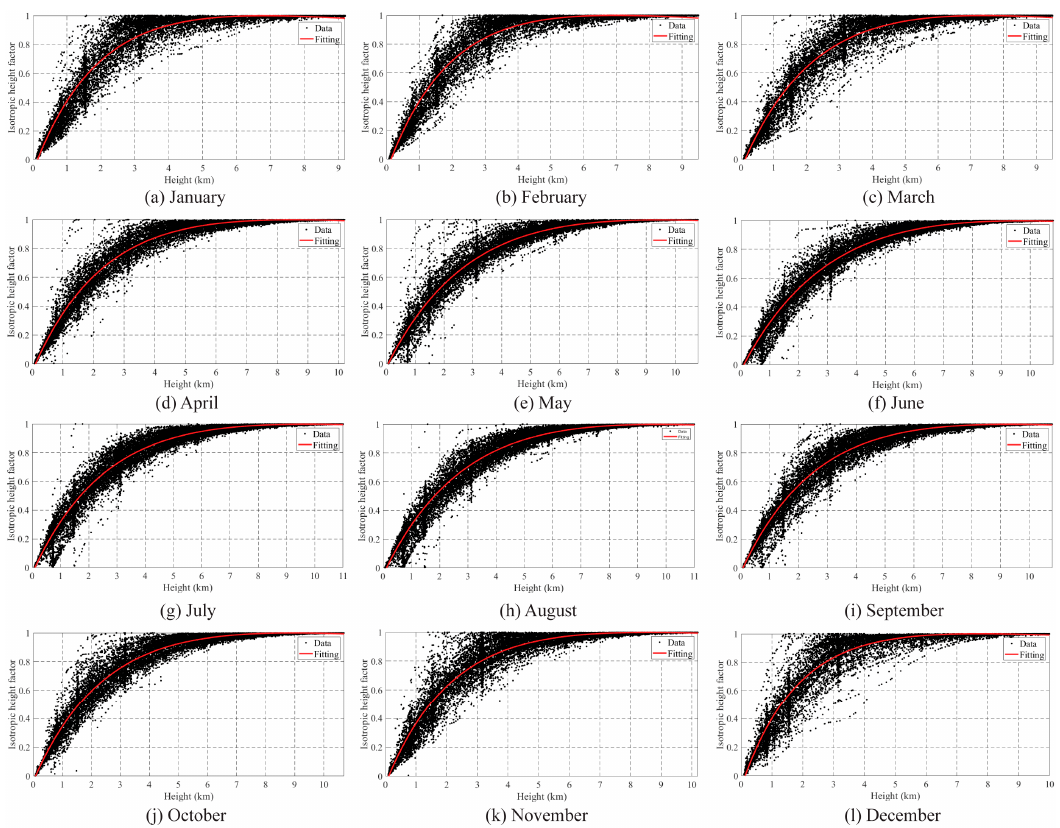
Figure 3. The isotropic height factor changes with height in different months. (a) January; (b) February; ( c ) March; ( d ) April; ( e ) May; ( f ) June; ( g ) July; ( h ) August; ( i ) September; ( j ) October; ( k ) November; (c) March; (d) April; (e) May; (f) June; (g) July; (h) August; (i) September; (j) October; (k) November; and ( l ) December. and (l) December.